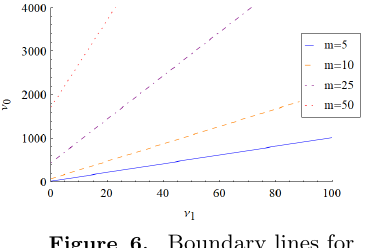
Figure 6. Boundary lines for comparison of T 1 and T 9 .